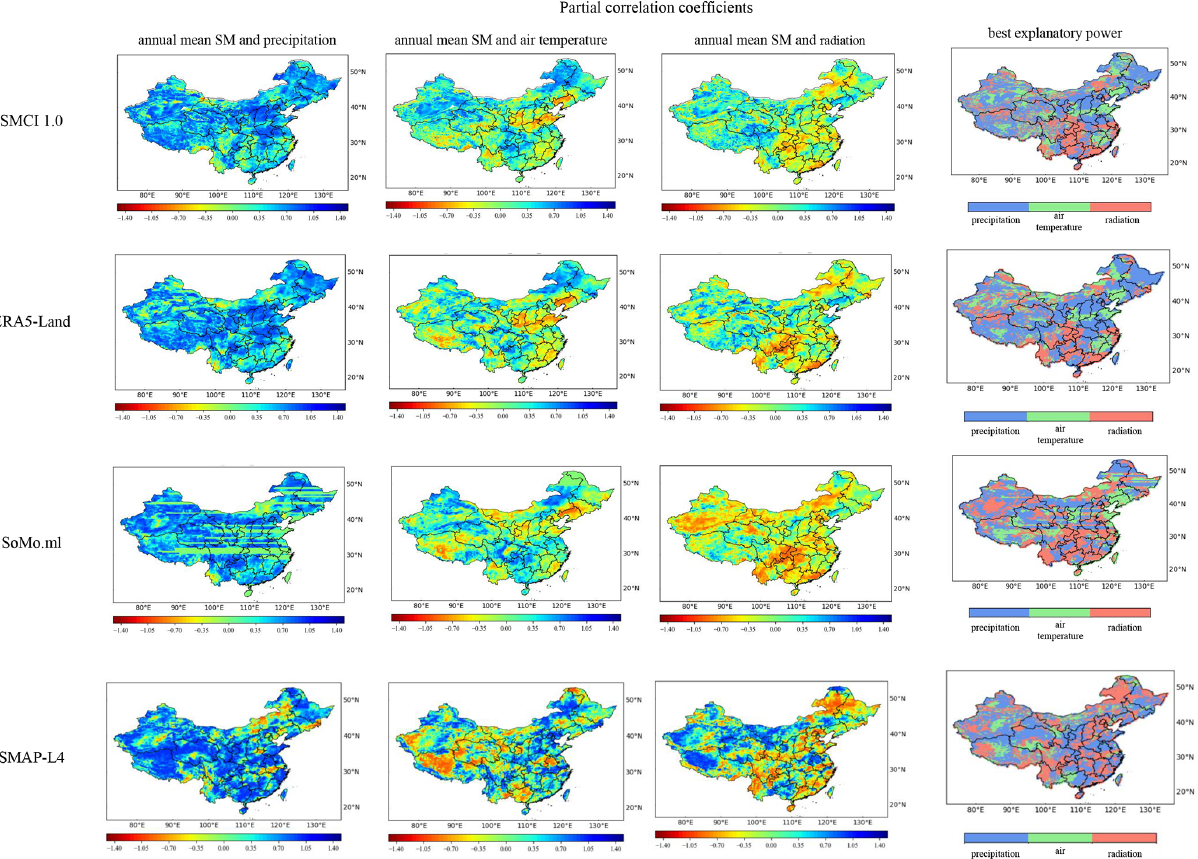
Figure 9. Partial correlation coefficients between annual mean SM and precipitation (the first column), air temperature (the second column), and radiation (the third column) for the different gridded SM products. The fourth column represents the best explanatory power (highest absolute partial correlation) for the interannual variability in SM for the different gridded SM